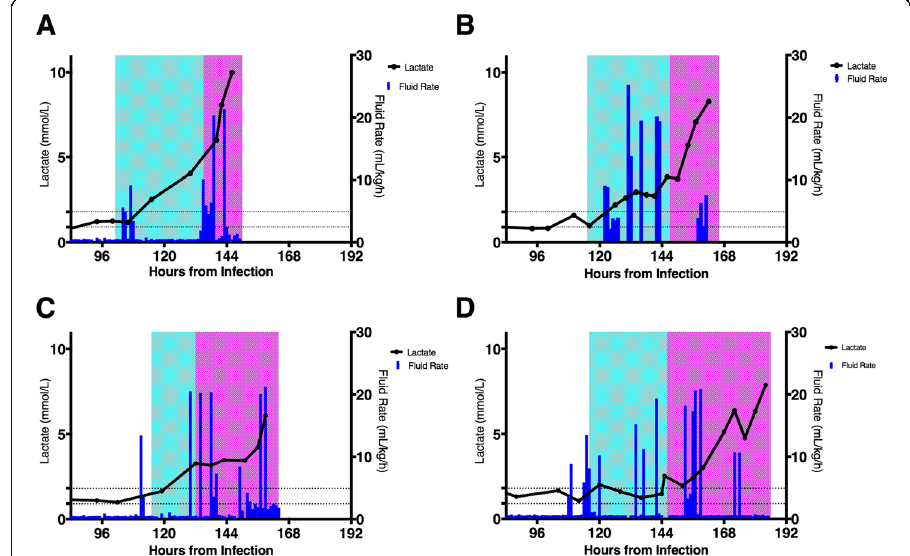
Fig. 4 Lactate values over time. This figure trends lactate values over time for the four infected animals. a – d NHP1 – 4, respectively. a – c The lactate values over time (in black) for NHP1, NHP2, and NHP3, respectively. The blue columns represent bolus fluids. The horizontal dotted lines represent the normal value range. The cyan-shaded areas represent compensated shock while the magenta-shaded areas represent decompensating